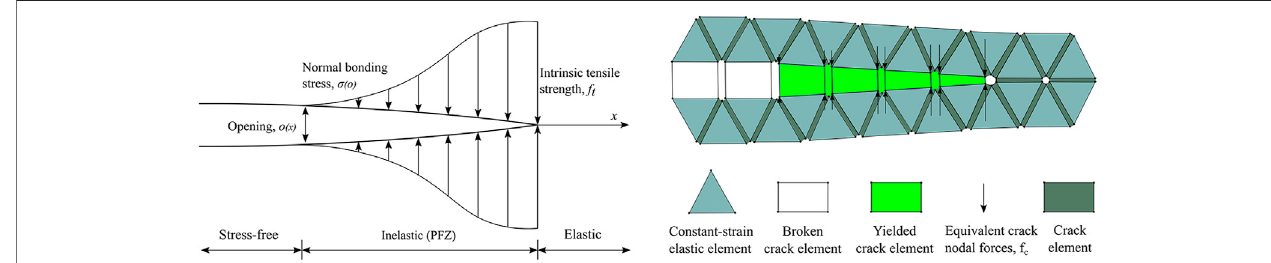
FIGURE 3 | (A) Fracture process zone (FPZ) and (B) Numerical characterization in FDEM.